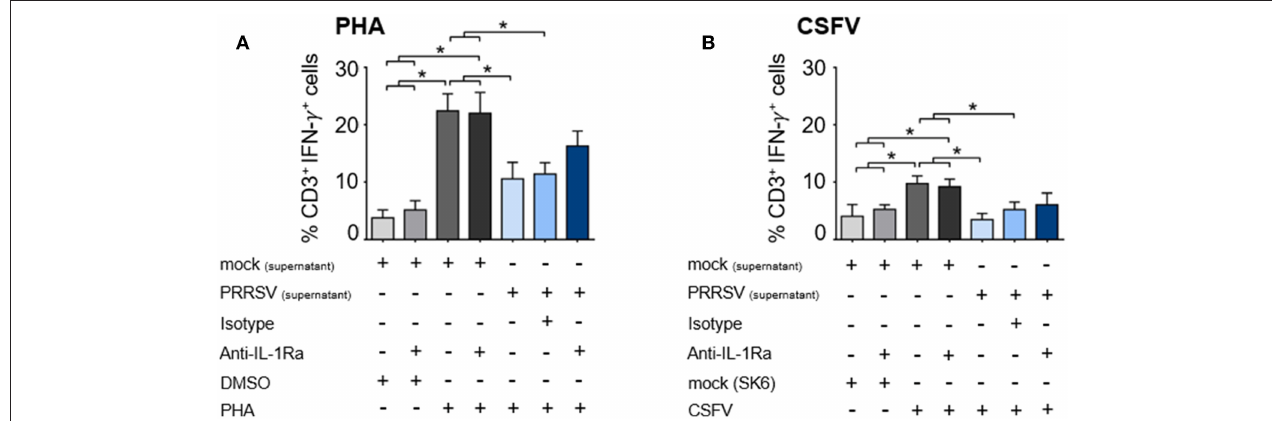
FIGURE 5 | PRRSV-induced IL-1Ra was not involved in suppression of IFN- γ -producing T lymphocytes in both (A) polyclonal and (B) recalled CSFV responses. The supernatants obtained from type 2 PRRSV or mock (MARC-145 cell lysate) were pretreated with anti-IL-1Ra Ab for 2h prior to addition into the culture. PBL or PBMC were cultured with PHA, CSFV or controls for 48h, in the presence of the pretreated supernatants. ± indicates presence/absence of indicated treatment within the culture. Data represents mean ± SD from 5 pigs. Statistical significance was analyzed using ANOVA followed by Tukey’s test. * indicates significant difference at p < 0.05.